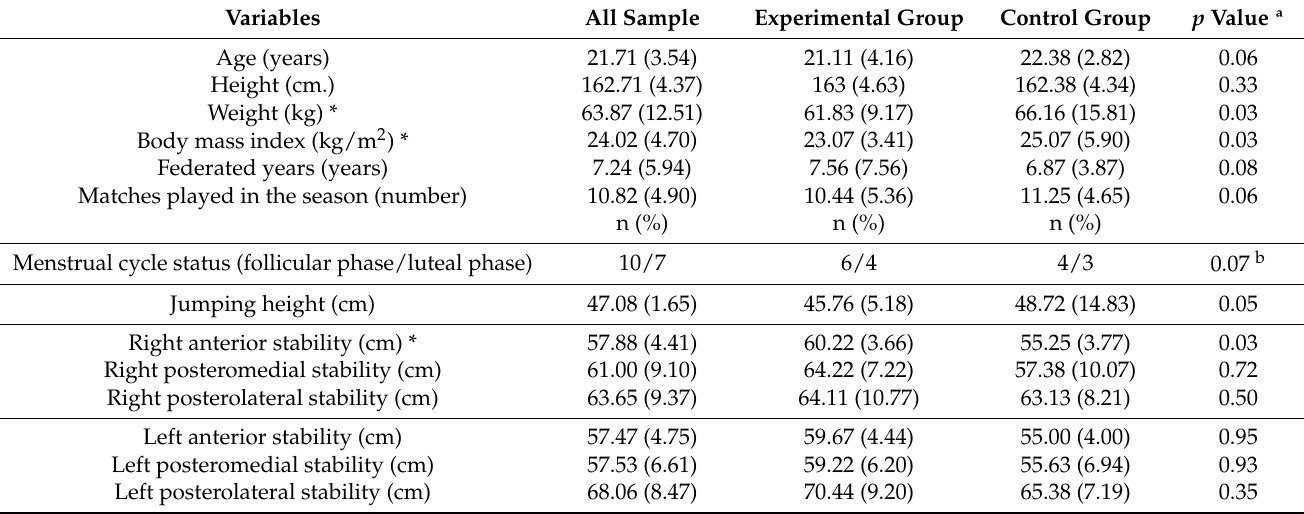
Table 1. Descriptive analysis (mean and standard deviation) at baseline of the total sample, and according to study group.